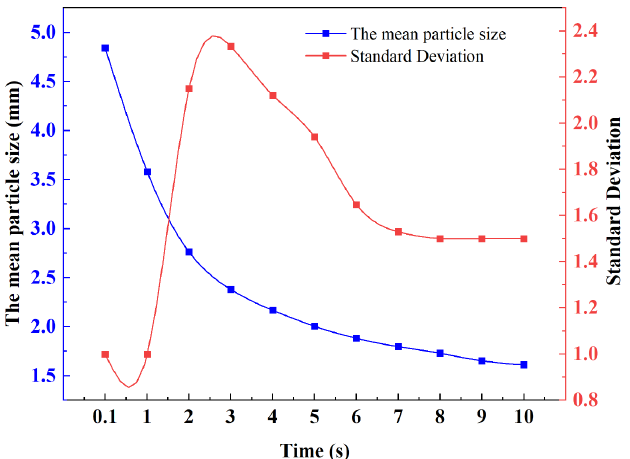
Figure 13. Mean and standard deviation of particle